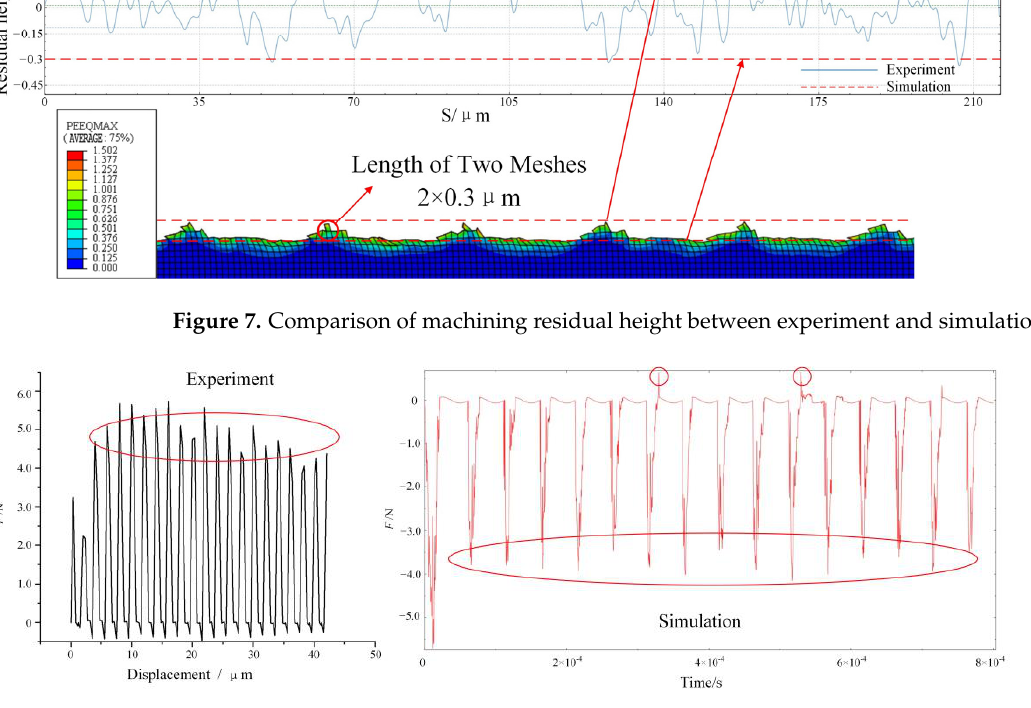
Figure 8. Comparison of cutting force between experiment and simulation.